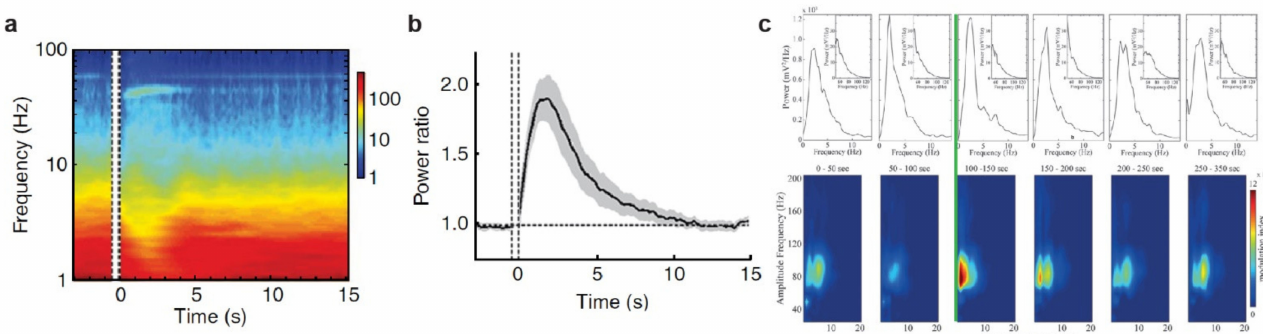
Figure 3. The causal effect of the cholinergic and dopaminergic system on neural oscillations: ( a ) Spectrogram of cortical LFP around nucleus basalis stimulation. ( b ) LFP power ratio (power at 10–100 Hz over power at 1–10 Hz) after nucleus basalis stimulation. Adopted from [128] with permission. ( c ) Dopaminergic receptor activation changed phase–amplitude coupling in mPFC. Adopted from